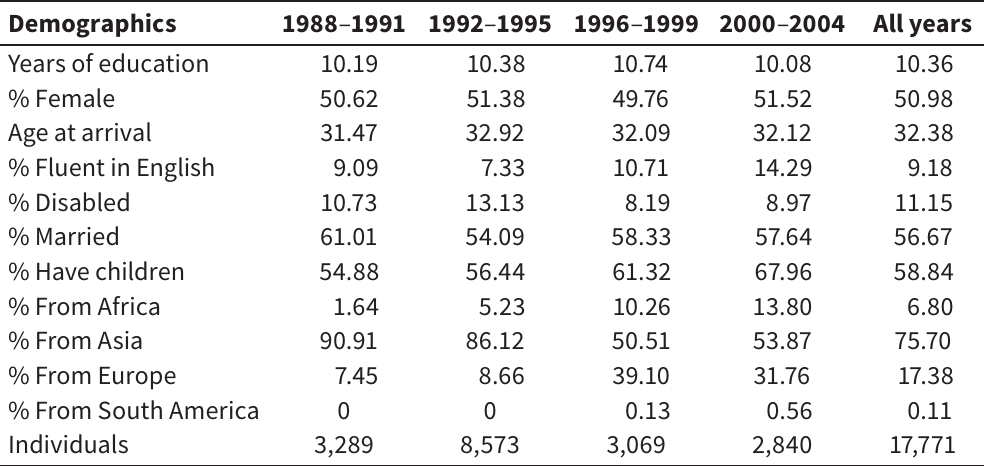
Summary statistics by year of